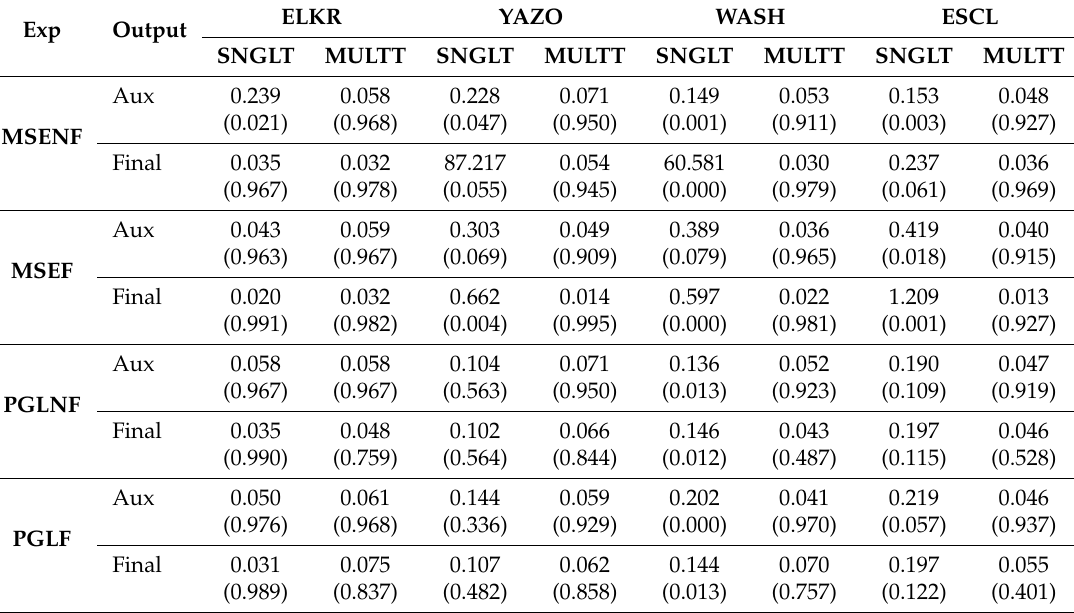
Table 7. Performance metrics for SNGLT and MULTT experiments performed on the training time period (TIME_E; 2016–2018) for all experiments: MSENF (MSE loss function, no SAT flagging), PGLNF (physics-guided loss, no SAT flagging), MSEF (MSE loss function, SAT flagging), and PGLF (physics-guided loss, SAT flagging). Performance metrics are shown for both auxiliary and final outputs, indicating whether the LSTM output (AUX) or hybrid output (FINAL) had better performance on the test set, i.e., if weather time series were sufficient to accurately predict SMAP SM or if the hybrid architecture yielded better accuracy. RMSEs and are listed above parenthetical R 2